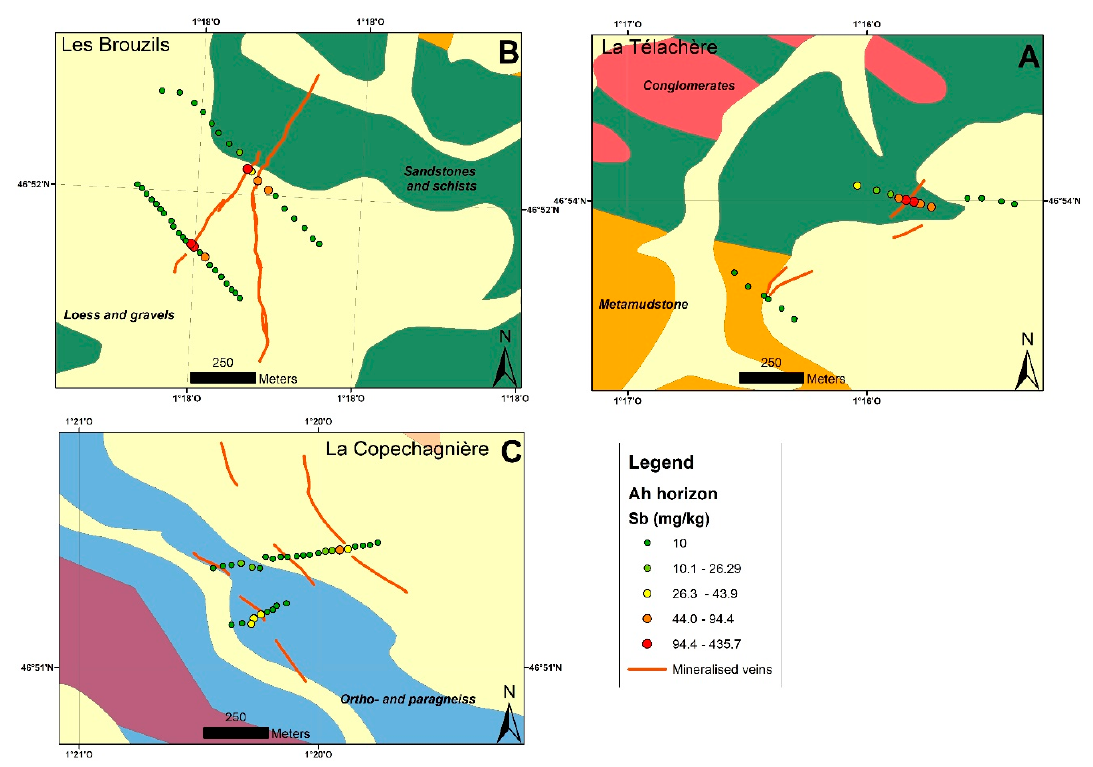
Figure 12. Sb map of Ah horizon samples, (pXRF measurements in mg/kg). ( A ): La Télachère; ( B ): Les Brouzils; ( C ): La Copechagnière.